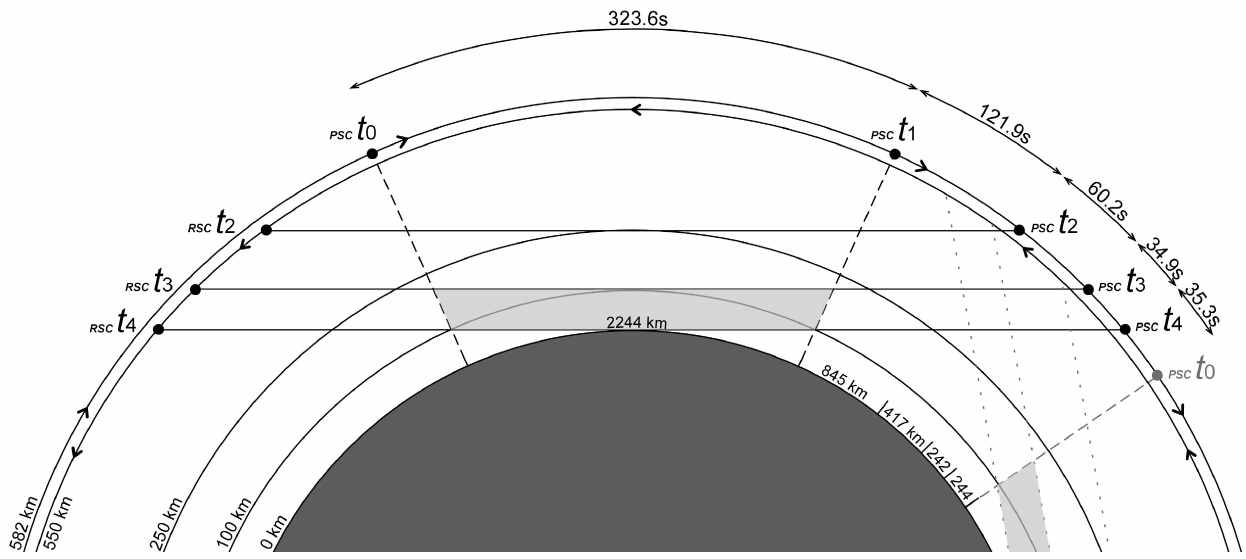
Figure 2. Sequence of one set of nadir and limb measurements, with the time for each part of the sequence shown in seconds. The observed region is shown hatched. The outermost orbit is that of the primary spacecraft (PSC; 582 km altitude, shown traveling clockwise), with the orbit of the retroreflector spacecraft just inside (RSC; 550 km altitude, traveling anticlockwise). At time t , the primary spacecraft begins making nadir measurements. At 0 time t the nadir measurement ceases, and the primary spacecraft searches for and locks 1 onto the retroreflector. Limb measurements begin at t with calibration, then the collection 2 of scientific data from t to t . There is then some free time before the start of the next 3 4 measurement sequence as the next retroreflector comes into view (shown in grey). Ray bending due to atmospheric refraction is unaccounted